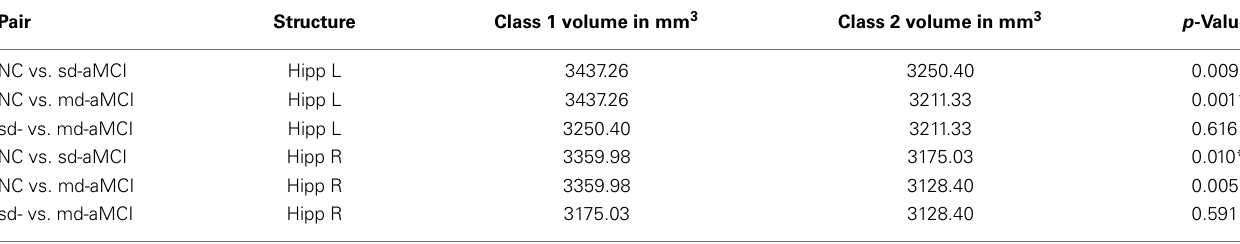
Table 3 |Volumes of hippocampi (in mm 3 ) of the a MCI sub-types and normal controls used in this study .